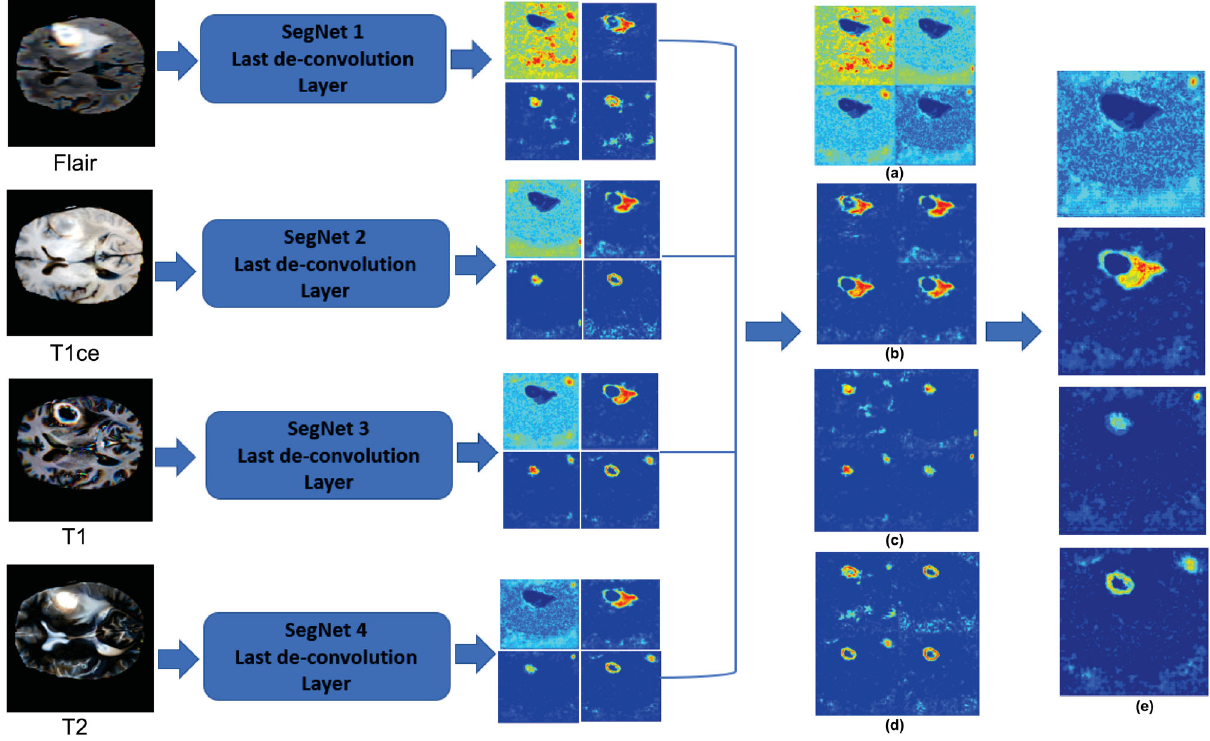
Fig. 4 Selection process of maximum feature maps. (a) Background. (b) Edema. (c) Enhancing tumor. (d) Necrosis. (e) Maximum feature